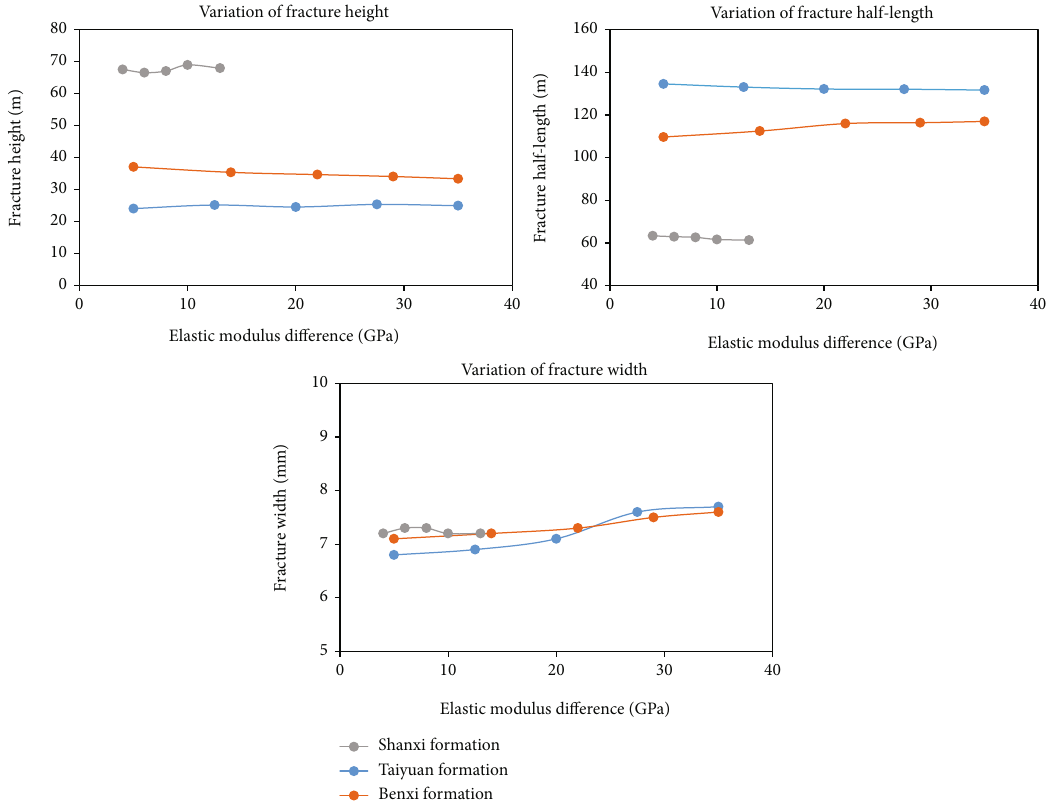
Figure 7: Variation of hydraulic fracture shape with the elastic modulus di ff